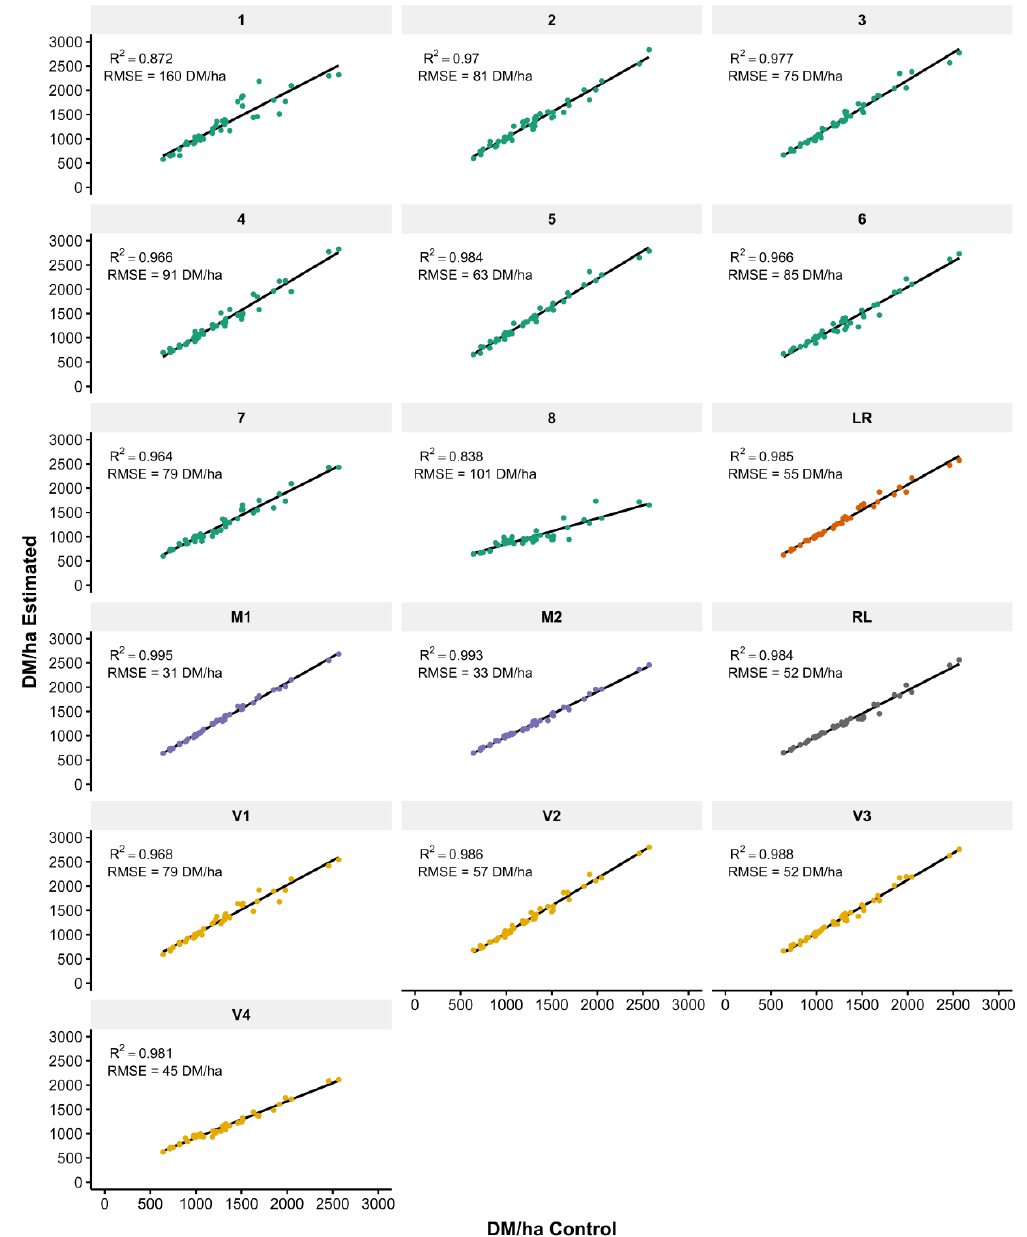
Figure 5. Linear regressions showing the coefficients of determination (R 2 ) and root mean square error (RMSE) of the different walking patterns evaluated and the zigzag pattern (considered as the control mean). 1 to 8 = individual transects from 1 to 8 ( ● ); LR = all left to right transects ( ● ); M = two M-shape patterns ( ● ); RL = all right to left transects ( ● ); V = four V-shape patterns ( ● ).